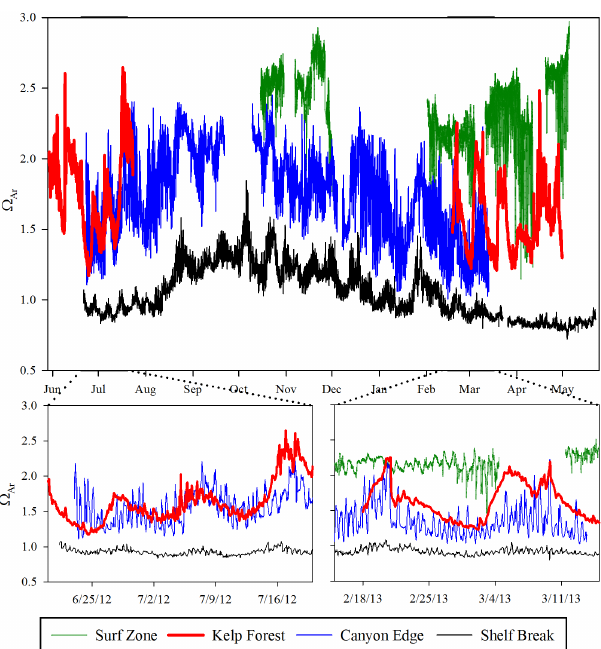
Figure 6. Time series of p CO 2 calculated from sensor pH and TA est between June 2012 and June 2013. The two lower panels are month- long snapshots. p CO 2 is reported at in situ conditions.